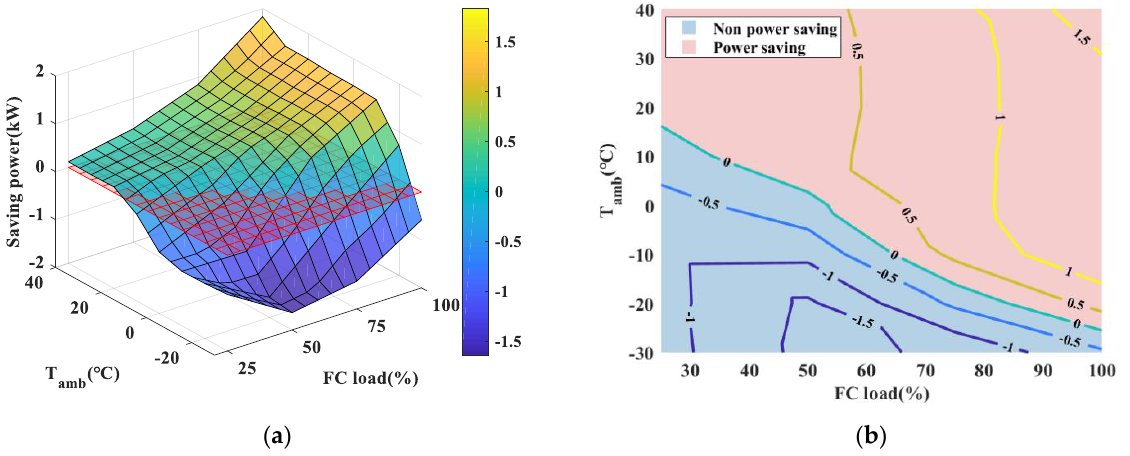
Figure 12. Total parasitic power saving results: ( a ) Saving power as a function of ambient temperature and FC load; ( b ) State division of the cold energy utilization system.